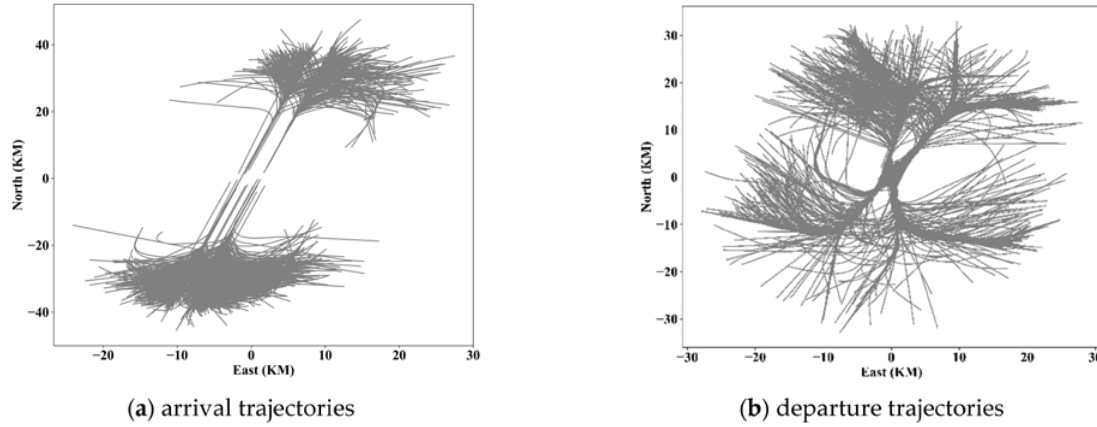
Figure 3. Some arrival and departure trajectories in Guangzhou Baiyun International Airport terminal